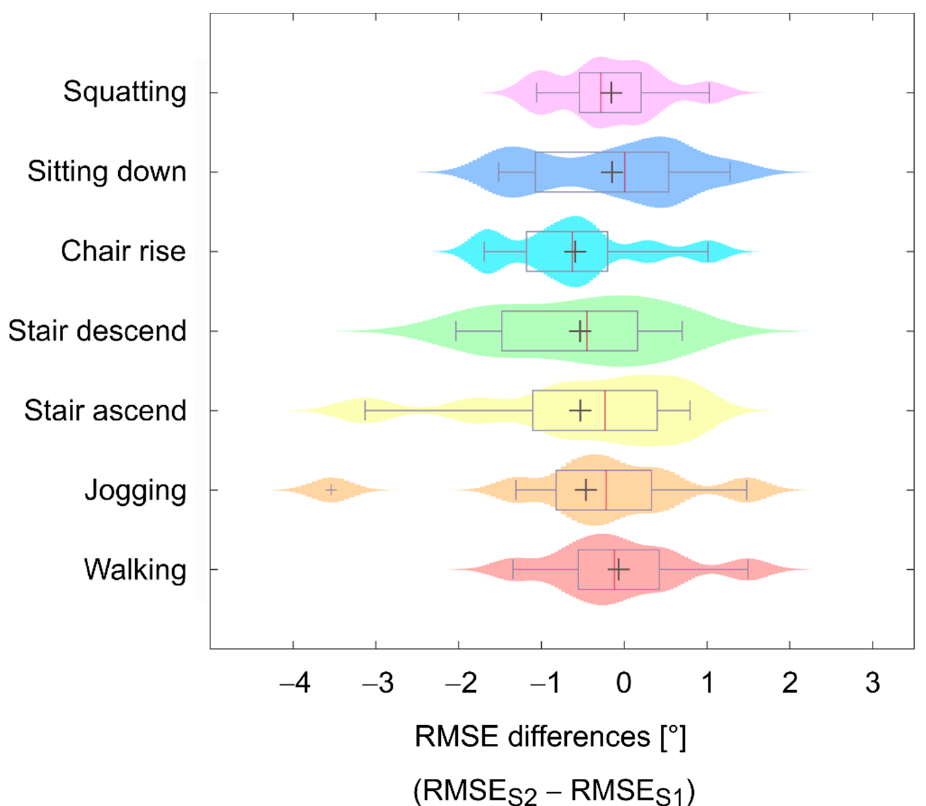
Figure 5. Distribution of root mean square error (RMSE) differences between session 1 (S1) and session 2 (S2) for each investigated activity obtained from the subgroup of nine participants; mean differences within the boxplots are represented by grey crosses, median differences within the boxplots are represented by red vertical lines, shaded areas represent the probability density of the data; the wider shaded areas indicate an accumulation of datapoints and narrow shaded areas, which are mostly present at the edges of each distribution, indicate scattered data points.